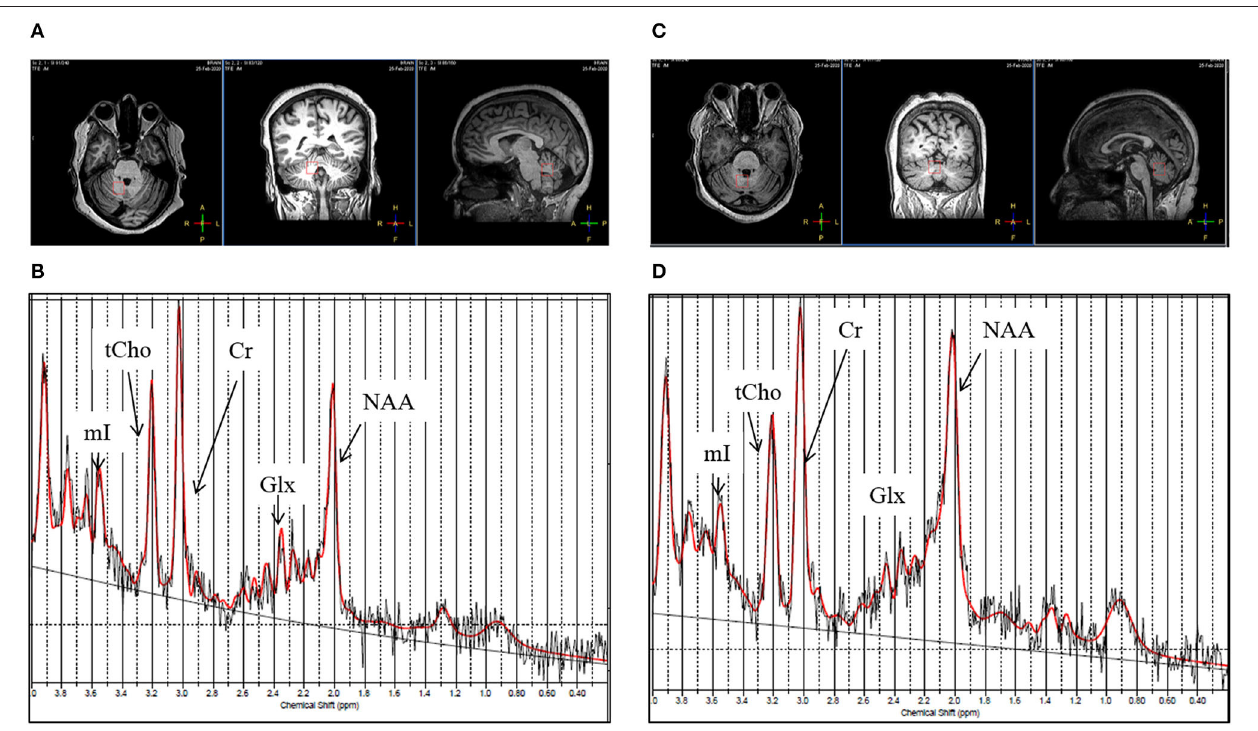
FIGURE 4 | (A) T1-weighted images of a healthy control (female, 44 years old) in axial, coronal and sagittal plane. (B) Representative LC Model fitted 1 H-magnetic resonance spectroscopy spectrum obtained from the right cerebellum region from the same healthy control from the voxel highlighted in (A) . (C) T1-weighted image of patient with gluten ataxia (female, 50 years old) in axial, coronal and sagittal plane. (D) Representative LC Model fitted 1 H-magnetic resonance spectroscopy spectrum acquired from the right cerebellum region of the same patient with gluten ataxia from the voxel highlighted in (C) .